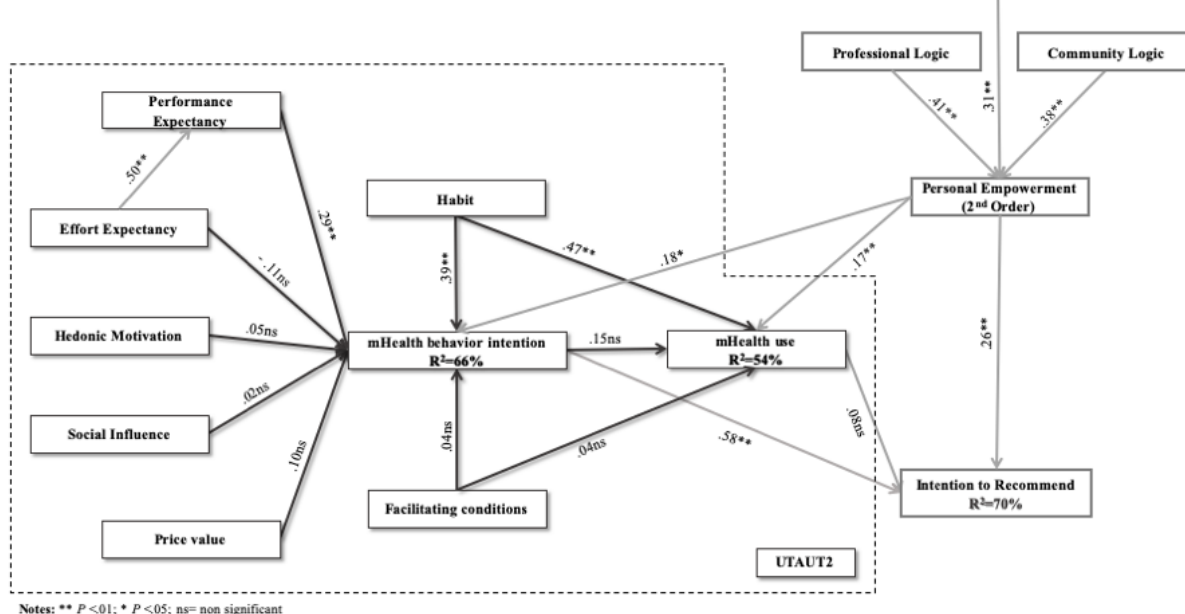
Figure 3. Structural model results for the chronic health conditions patients (CHCP) group and the without chronic health conditions (WCHC) group (in parentheses). Statistically significant relationships observed for both groups are presented in green. Significant relationships only in the WCHC group are presented in red. Results with no significant relationship in either group are presented in black with